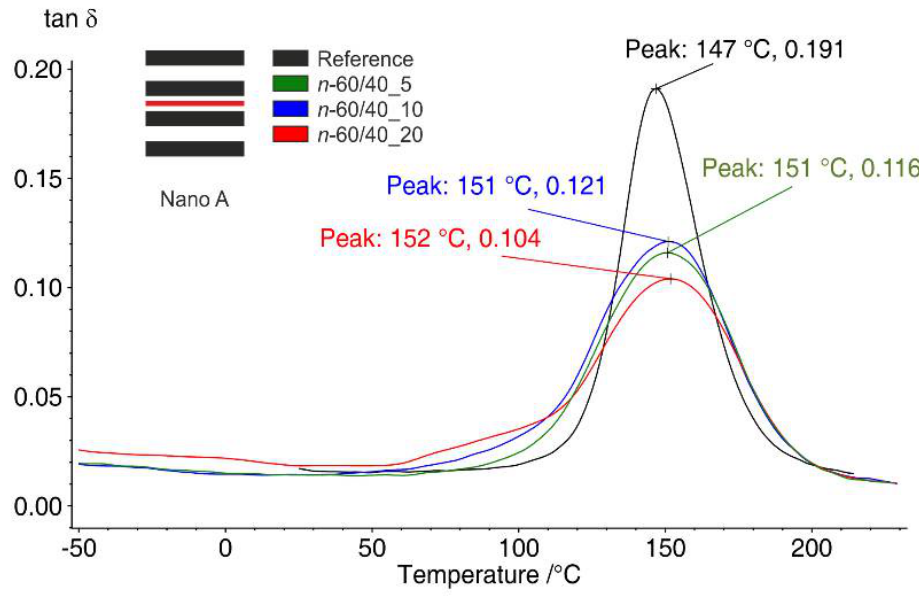
Figure 8. Tan δ curves of Nano A laminate configuration. Figure 8. Tanδ curves of Nano A laminate configuration. The fully nano-modified Nano F configuration shows, obviously, the highest broaden- ing of the tan δ curve, together with the highest enhancement of tan δ also at low tempera- tures (Figure 9).